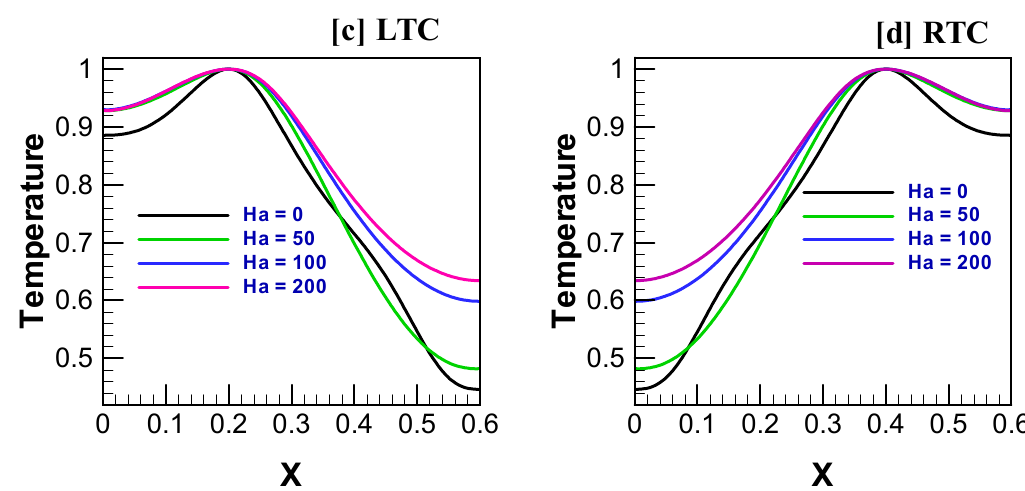
Figure 10. Variations of temperature with distance for different orientations of heated cylinders for Ha = 0–200, Ra = 10 5 and Pr = 0.71.